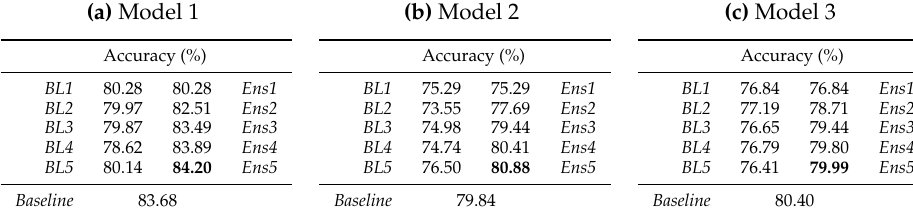
Table 11. Bagging results of baseline models on CIFAR 10 dataset.